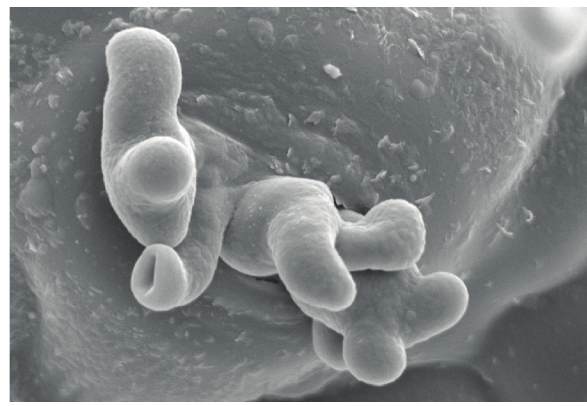
Figure 7. Sporangiophores in formation exiting from a stoma.